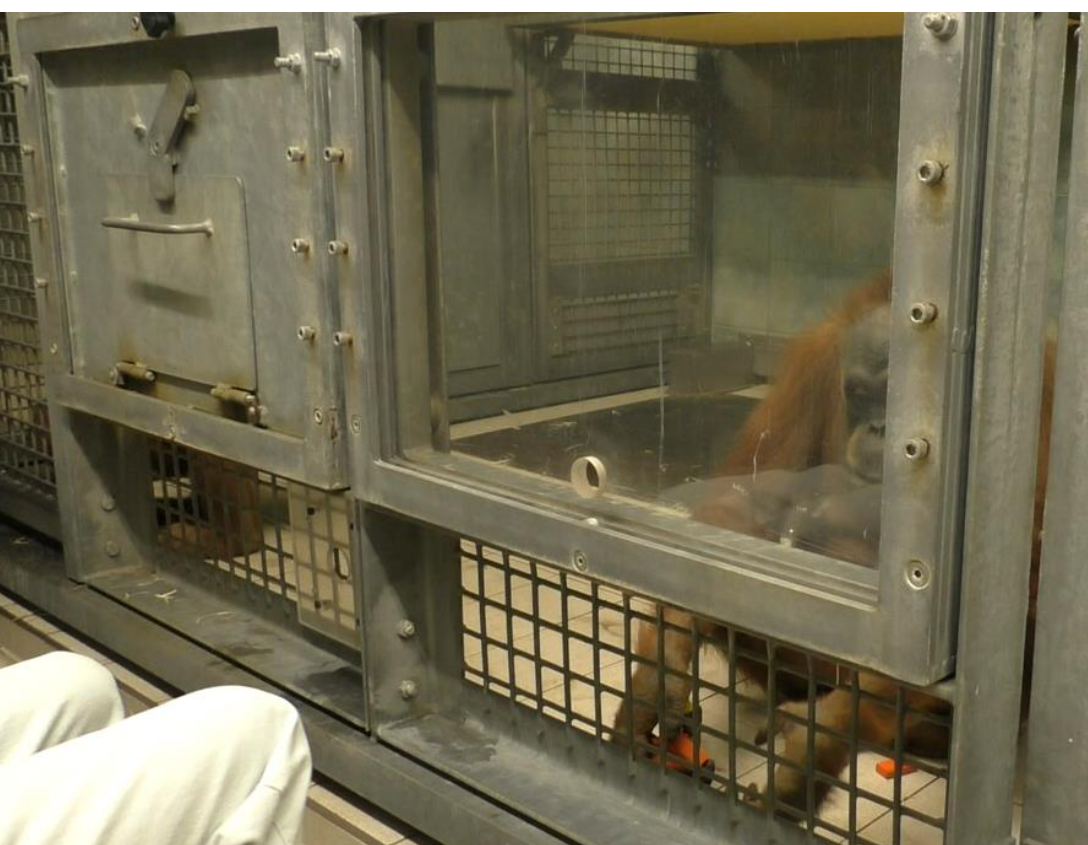
Figure 2. The experimental set-up. Objects were placed into the food hatch at the start of each trial (pictured to the left of the ape). Objects were exchanged through the lower mesh. Photo printed with permission from the Max Planck Institute of Evolutionary